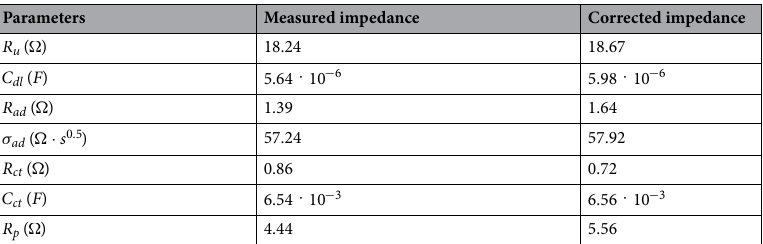
Table 1. Extracted parameters from fitting the measured and corrected impedance of NiHCF nanoparticles in 0.5 M K 2 SO 4 with the equivalent circuit (Fig. 5c. R u denotes the uncompensated cell resistance, C dl is the capacitance of the double layer, R ad is the adsorption resistance, σ ad is the Warburg coefficient of the cation in the liquid, R ct is the charge transfer resistance, C ct is the capacitor describing the mass transport in the solid and R p is the pore resistance 49 .